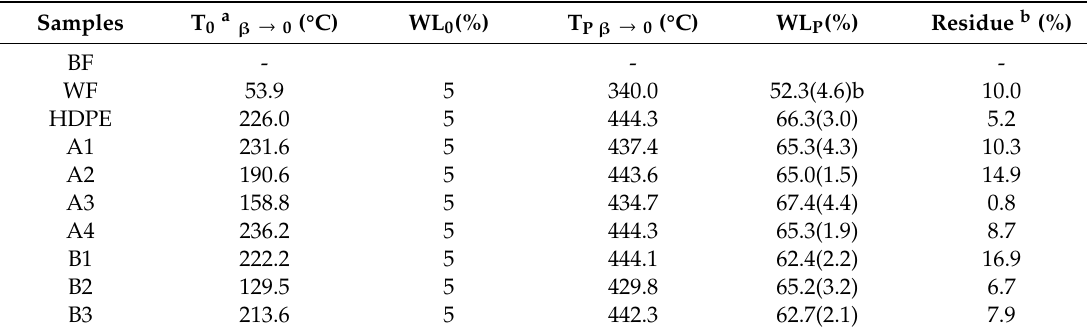
Table 5. Pyrolysis parameters ( β →